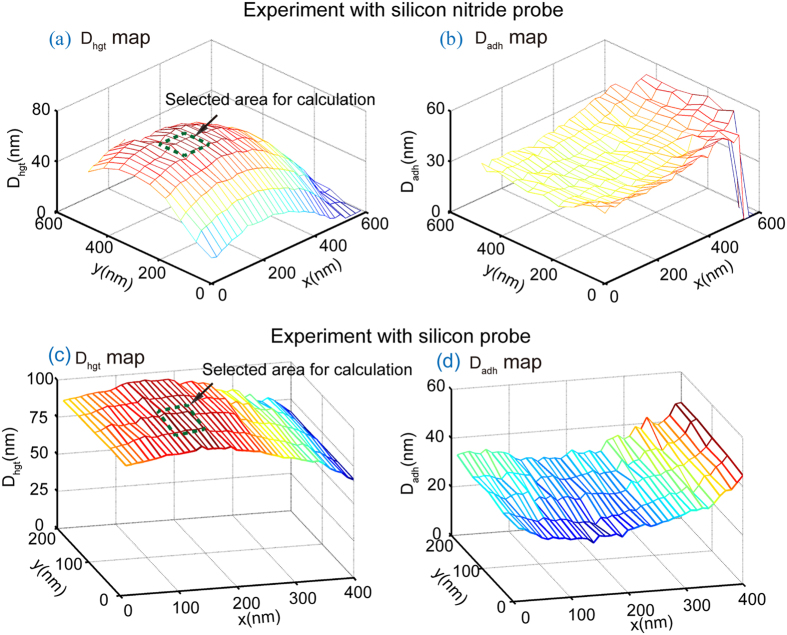
Constructed maps of Dhgt (a,c) and Dadh (b,d) for the experiment 1 (ORC 8 cantilever) and experiment 2 (RFESP cantilever), respectively.